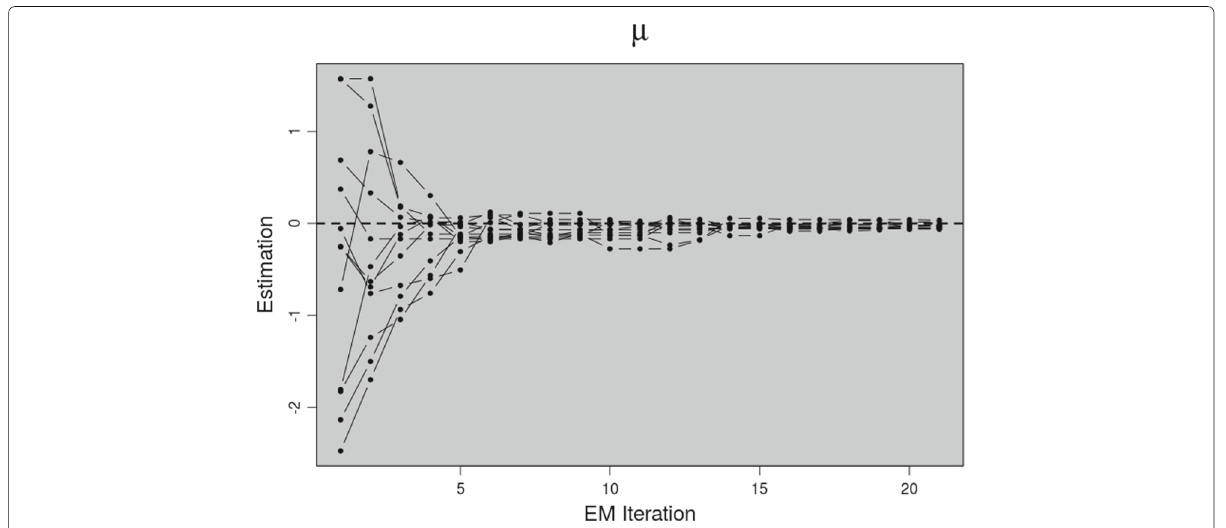
Fig. 6 SINE model - EM. Estimation of μ